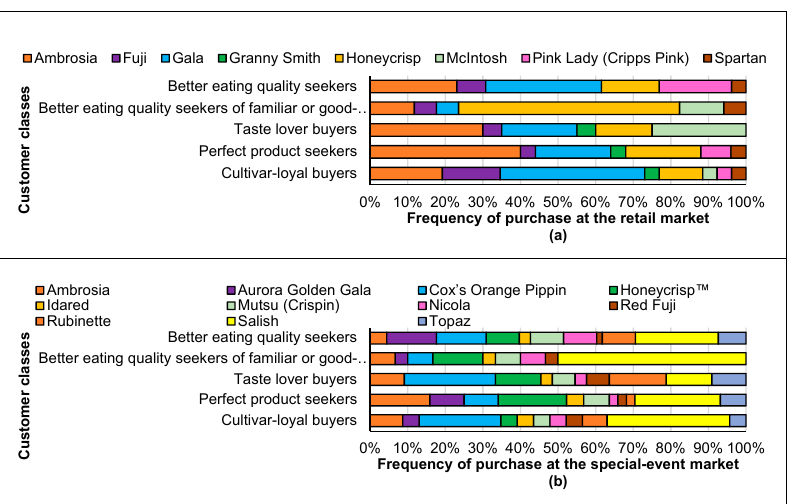
Figure 2. Apple cultivars purchased by five different classes of customers at the retail market ( a ) and special-event market ( b ). The age distribution of the respondents was different from the different classes of customers (Figure 3).